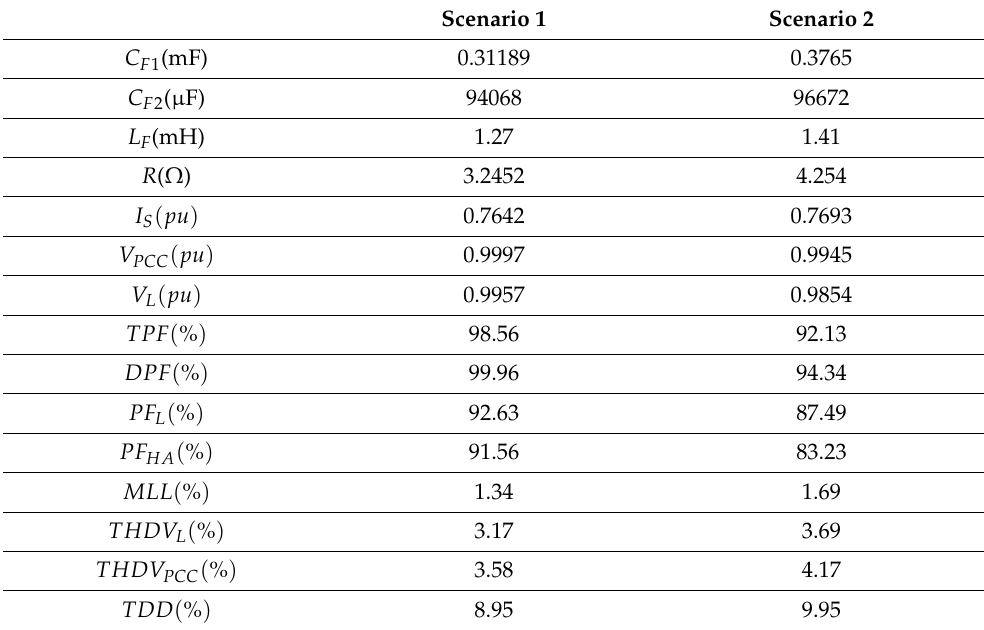
Table 5. The optimal filter parameters and results for the compensated system for the two